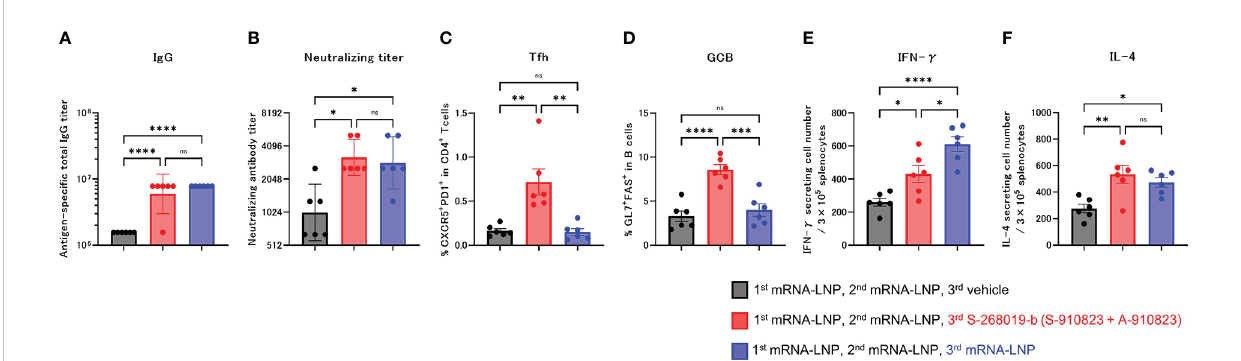
FIGURE 2 Heterologous booster dose of S-268019-b after primary immunization with mRNA-LNP induces robust Tfh cells and humoral immune responses. Balb/c mice were injected IM with mRNA-LNP as the fi rst and second immunizations, and mRNA-LNP or S-910823 mixed with A-910823 (S- 268019-b) as a booster dose, on days 0, 20, and 42, respectively (n=6/group). (A) Antigen-speci fi c total IgG titers in the sera on day 60. Each bar represents the GMT; error bars indicate the 95% con fi dence interval. Each circle represents the titer in individual mice. (B) Serum titers of neutralizing antibodies against SARS-CoV-2 on day 60. Each bar represents the GMT; error bars indicate the 95% con fi dence interval. Each circle represents the neutralizing antibody titer in individual mice. (C) Percentages of Tfh (PD1+CXCR5+) cells in TCRb+CD4+ cells and (D) percentages of GCB (FAS+GL7+) cells in CD19+ cells in the draining lymph nodes on day 60. Each bar represents the mean; error bars indicate the standard error of the mean. Each circle represents the percentages of Tfh and GCB cells in individual mice. (E – F) The number of cytokine-secreting cells in the spleen of immunized mice on day 60 was determined by ELISpot. Each bar represents the mean number of antigen-speci fi c spot-forming cells; error bars indicate the standard error of the mean. Each circle represents the antigen-speci fi c spot-forming cells in individual mice. Statistical signi fi cance